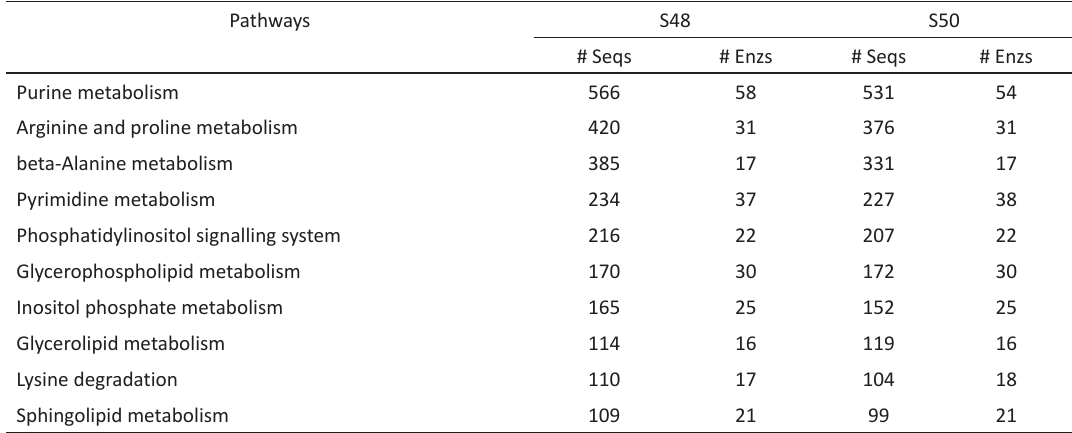
Table 2. KEGG pathway analysis. The table shows top ten KEGG pathways and corresponding number of gene sequences (#Seqs) and enzymes (#Enzs) in the data.